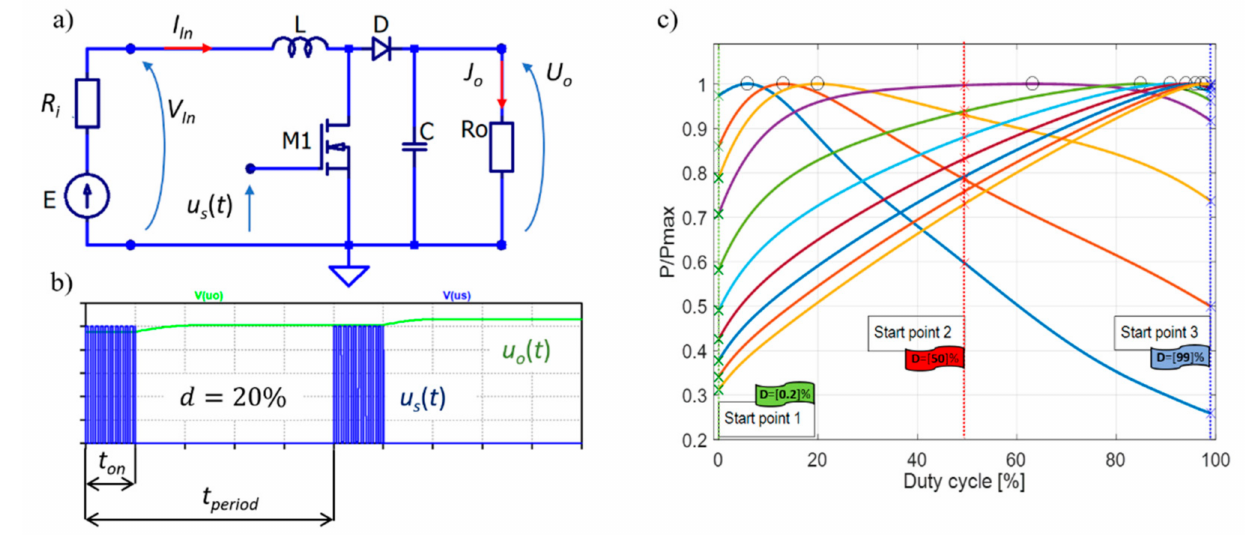
Figure 4. Simulation verification: ( a ) analyzed boost topology, ( b ) example signal controlling output voltage, ( c ) normalized load power vs. transistor gate signal duty cycle matching